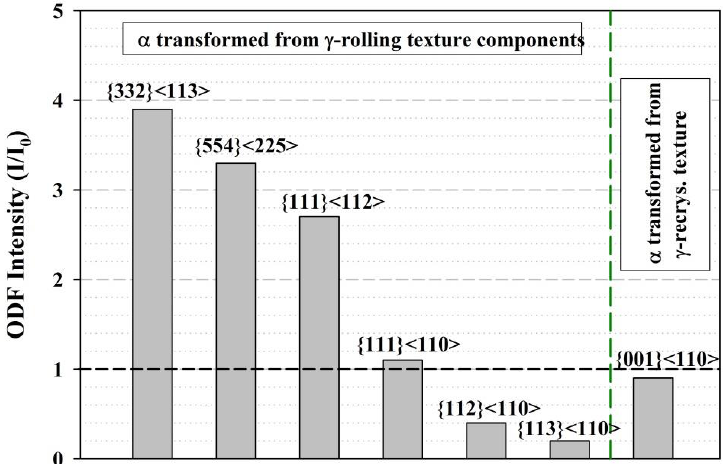
Figure 13. Major texture components in the untempered HR+Q sample.